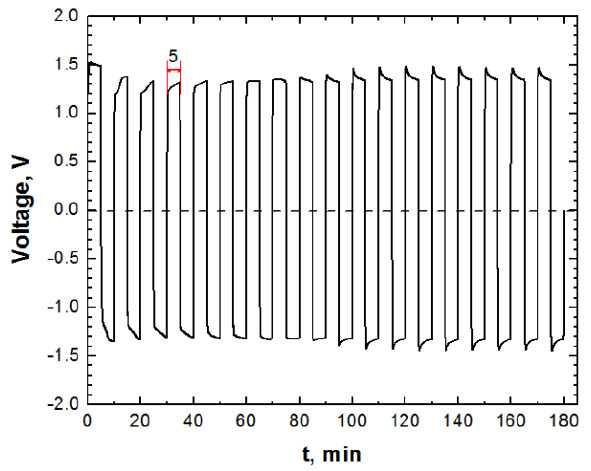
=26 mM, C =150 NaCl i